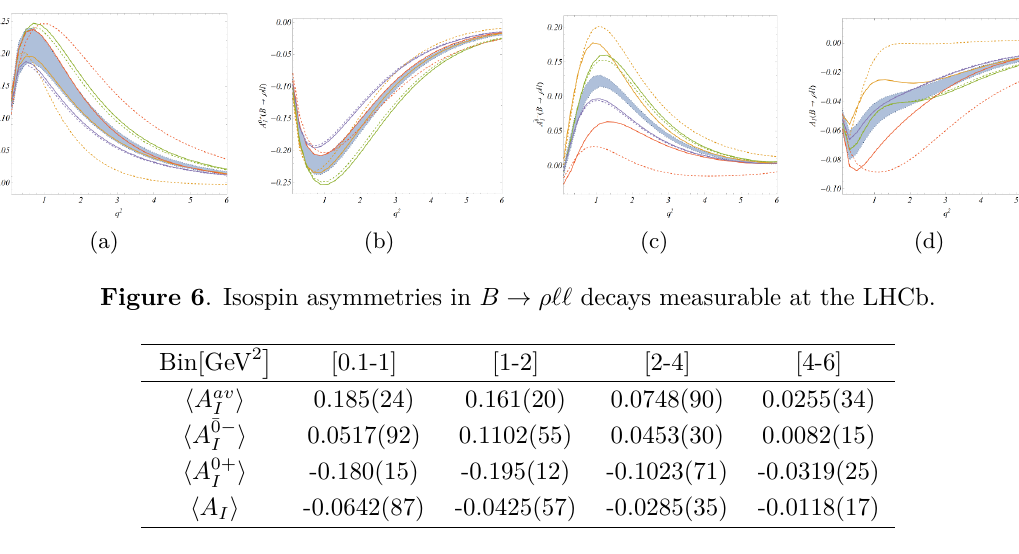
Table 16 . SM Predictions of isospin observables for B → ρ‘‘ defined in eqs. (4.20) and (4.23), re-